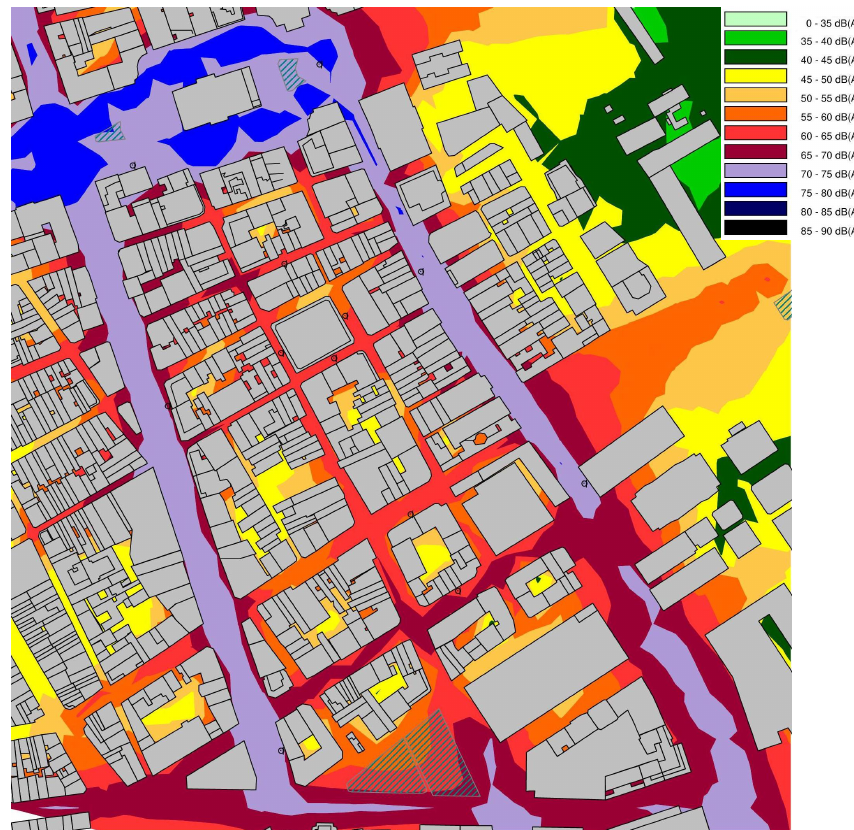
Figure 9: Noise map for the pandemic scenario.